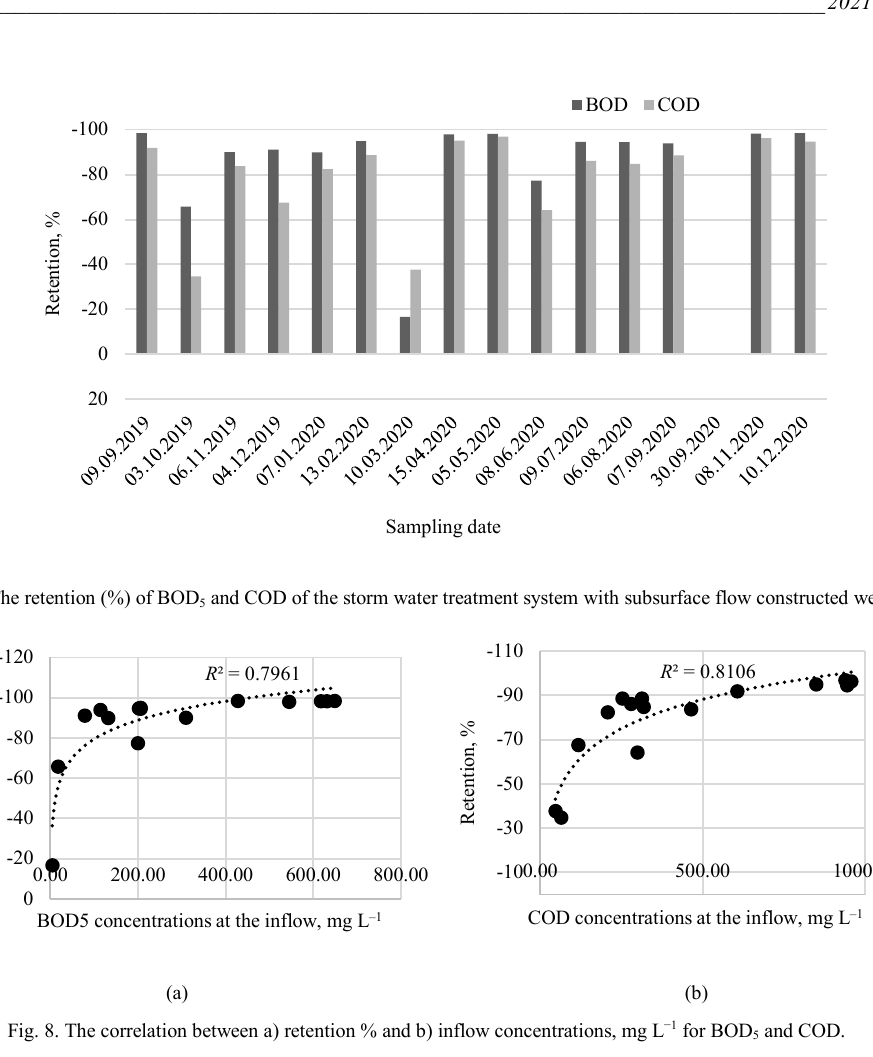
Fig. 8. The correlation between a) retention % and b) inflow concentrations, mg L − 1 for BOD 5 and